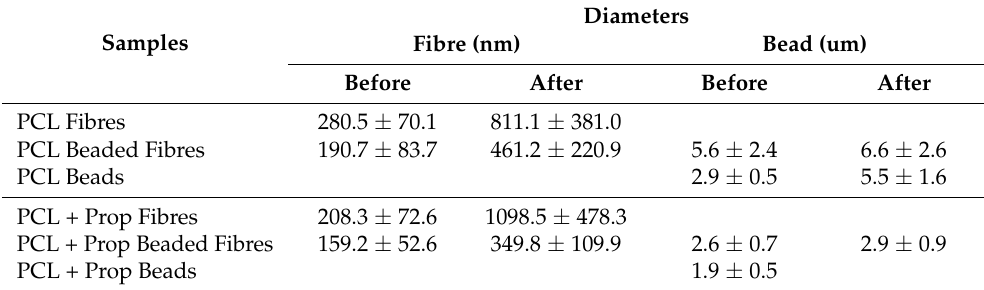
Figure 9. Scanning electron microscopy images of membranes with different morphologies after swelling and propolis release (48 h). PCL ( a – c ) and PCL + Prop ( d – f ). Table 5. Diameters before and after swelling and propolis release. Fibre and bead diameter after release assay measured in SizeMeter 1.1